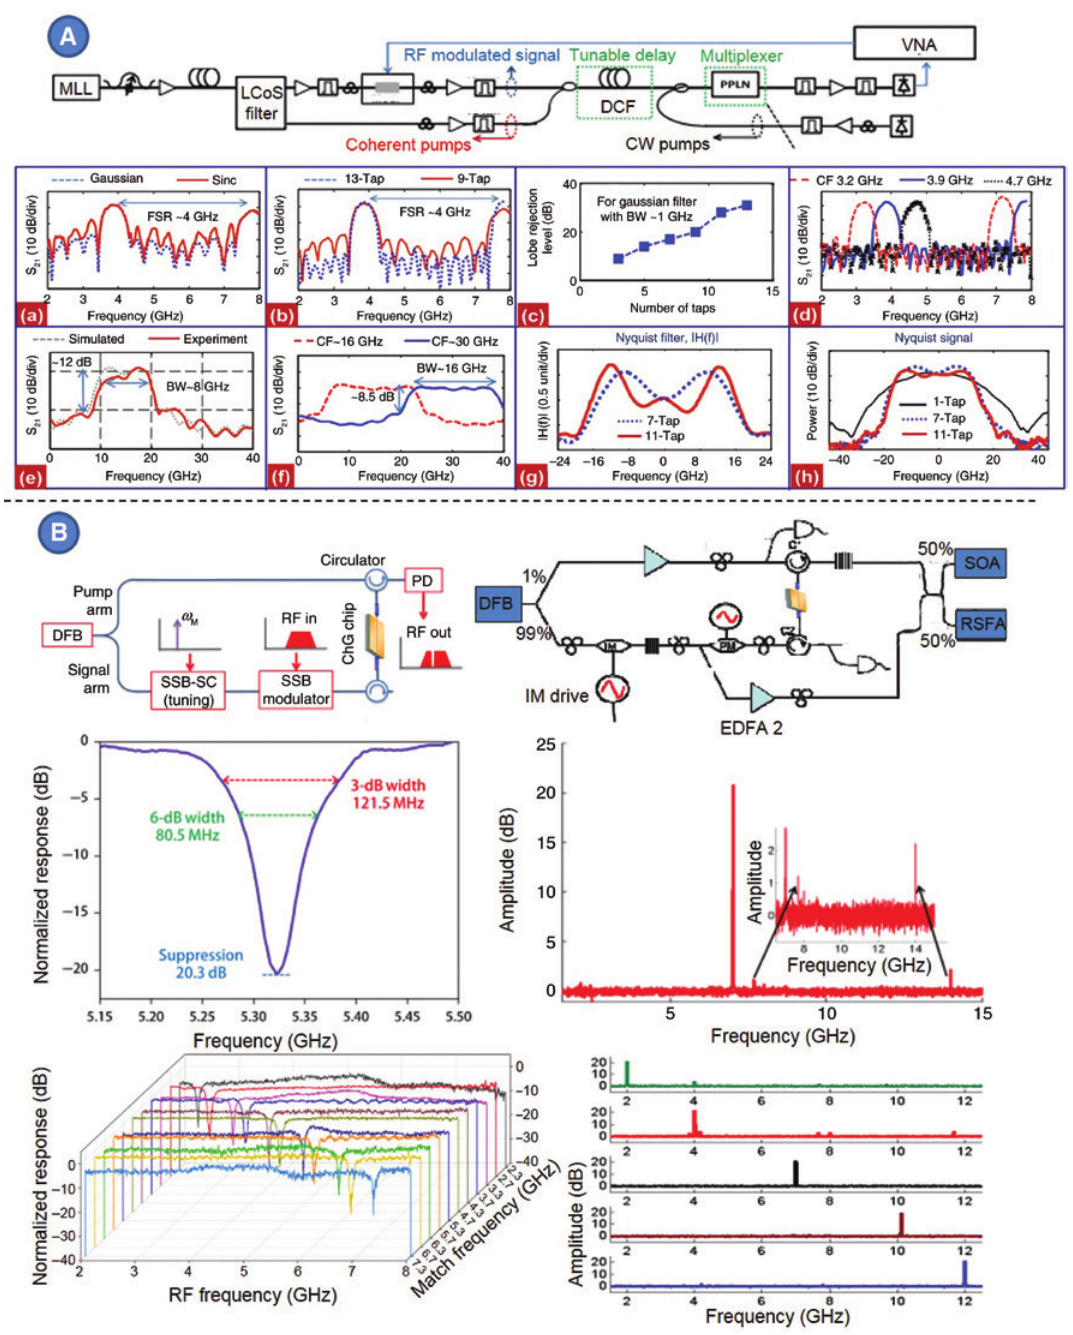
Figure 26: (A) An RF filter implemented using a PPLN waveguide [108] (Copyright in 2015, Optical Society of America). (B) Implementations of bandstop and bandpass RF filters based on SBS in an As